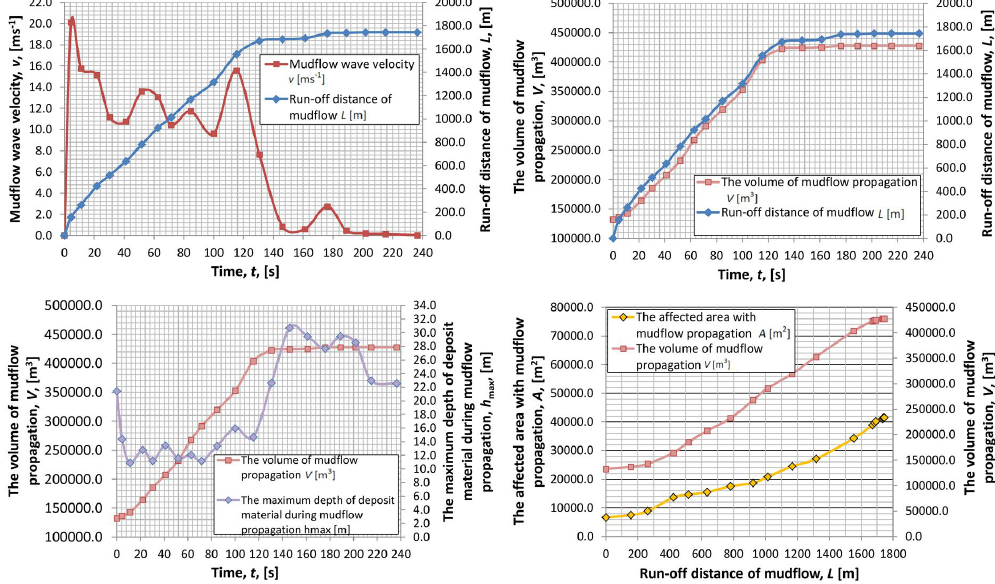
Figure 15. Visualization of dependence of individual output parameters with respect to time and runout distance of mudflow propagation: Simulation 1 with the application of the Egashira erosion law.